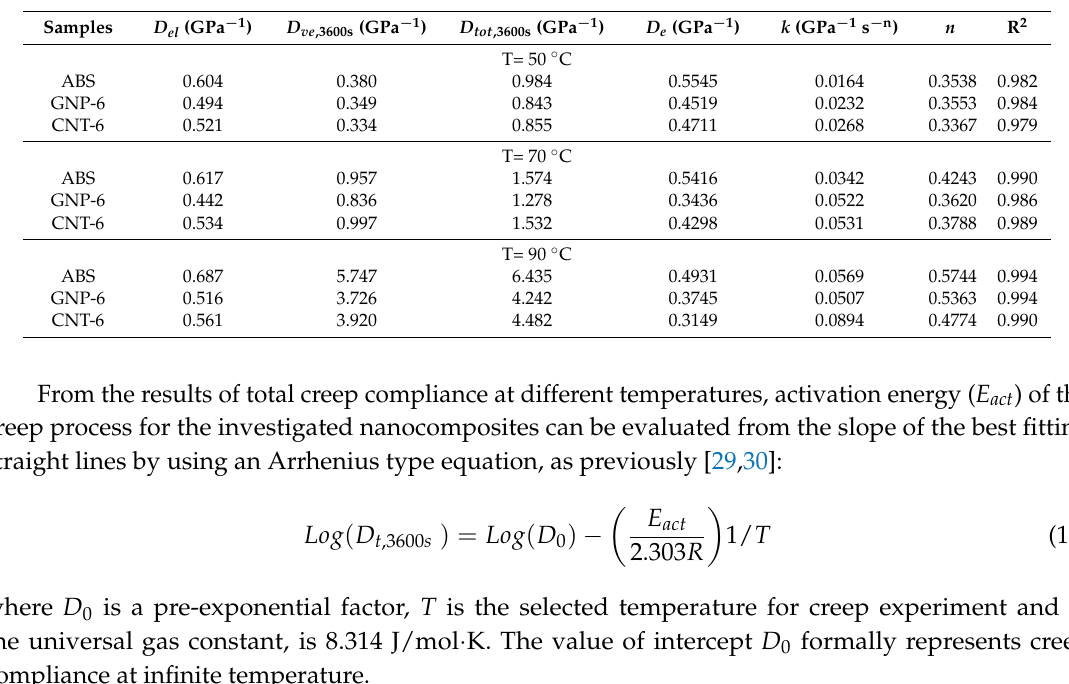
Table 4. Creep compliance data of ABS-graphene and ABS-CNT nanocomposites at different temperatures according Equation (17).